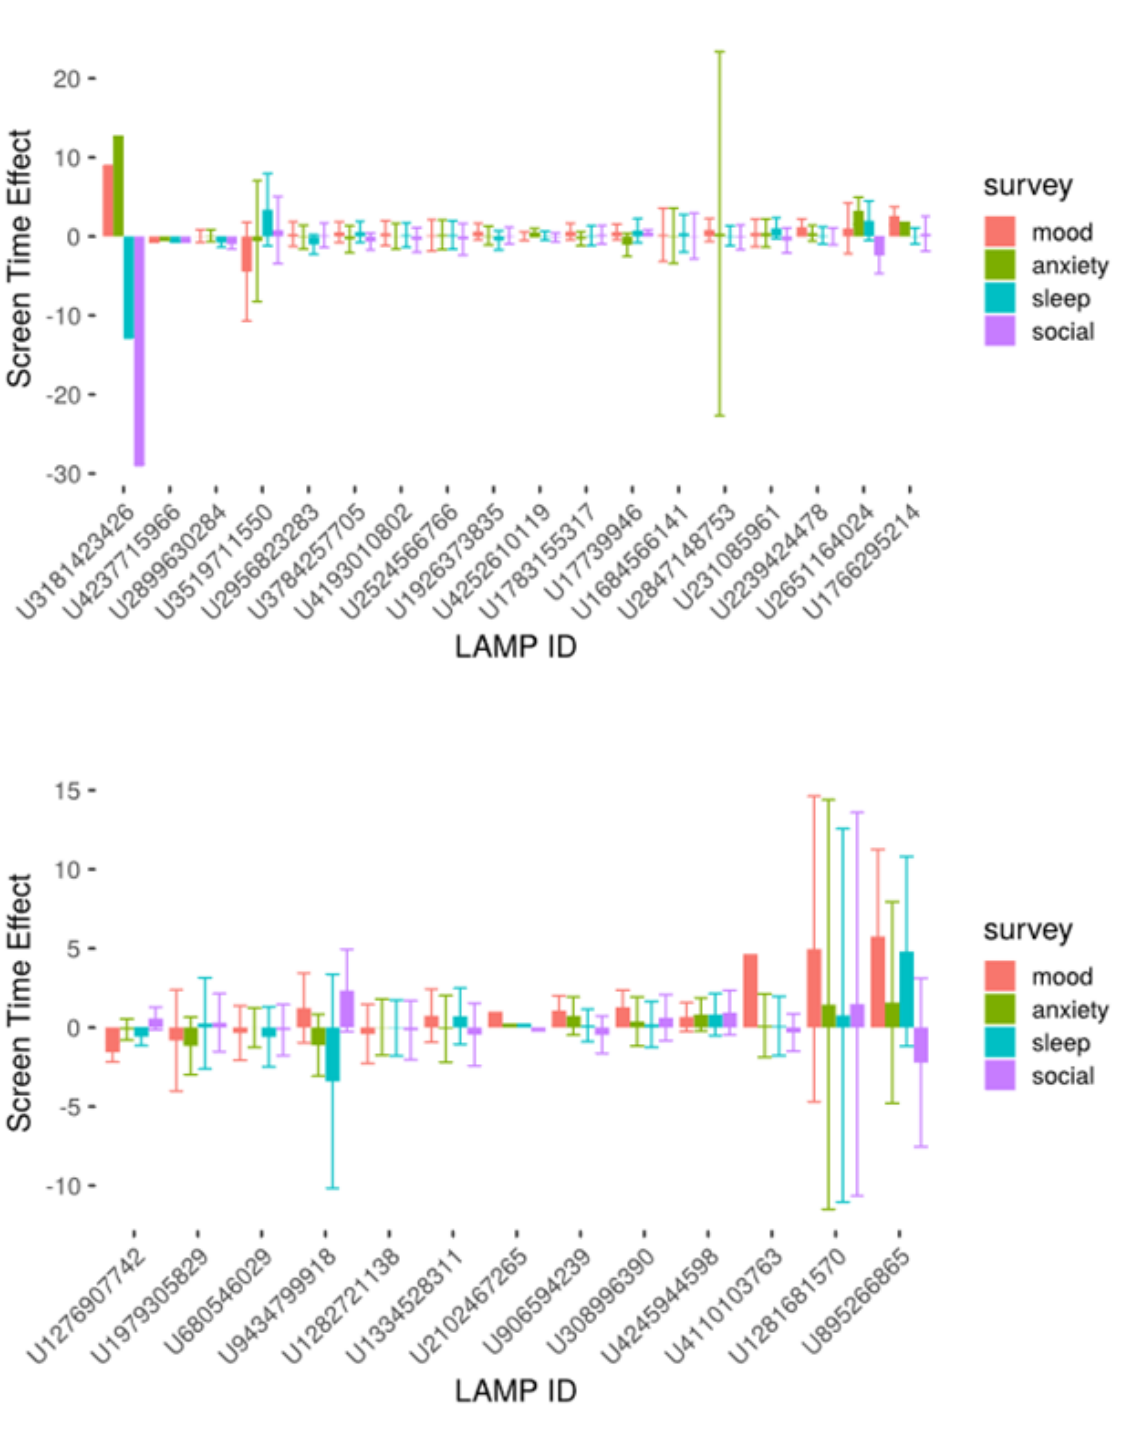
Figure 2. Individual effects of screen time on symptoms measured using the mindLAMP mobile phone app, plotted from low to high for (A) participants with a clinical diagnosis of schizophrenia (n=18) and (B) healthy controls (n=13), with self-reported survey scores in all